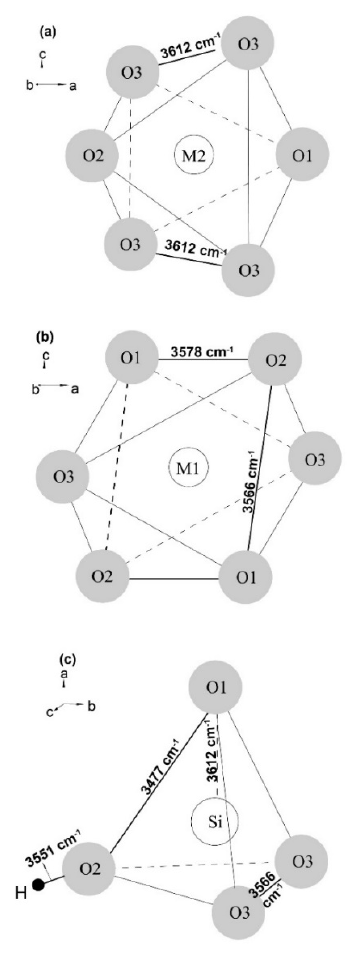
Figure 4. Sketch of ( a ) M2 octahedron, ( b ) M1 octahedron and ( c ) Si tetrahedron for forstertie, based on the single-crystal structure refinement from Hushur et al. [24]. The potential attributions for the OH bands in both the cases of M-substitution and Si-substitution are marked, which are in agreement with this polarized FTIR measurement.